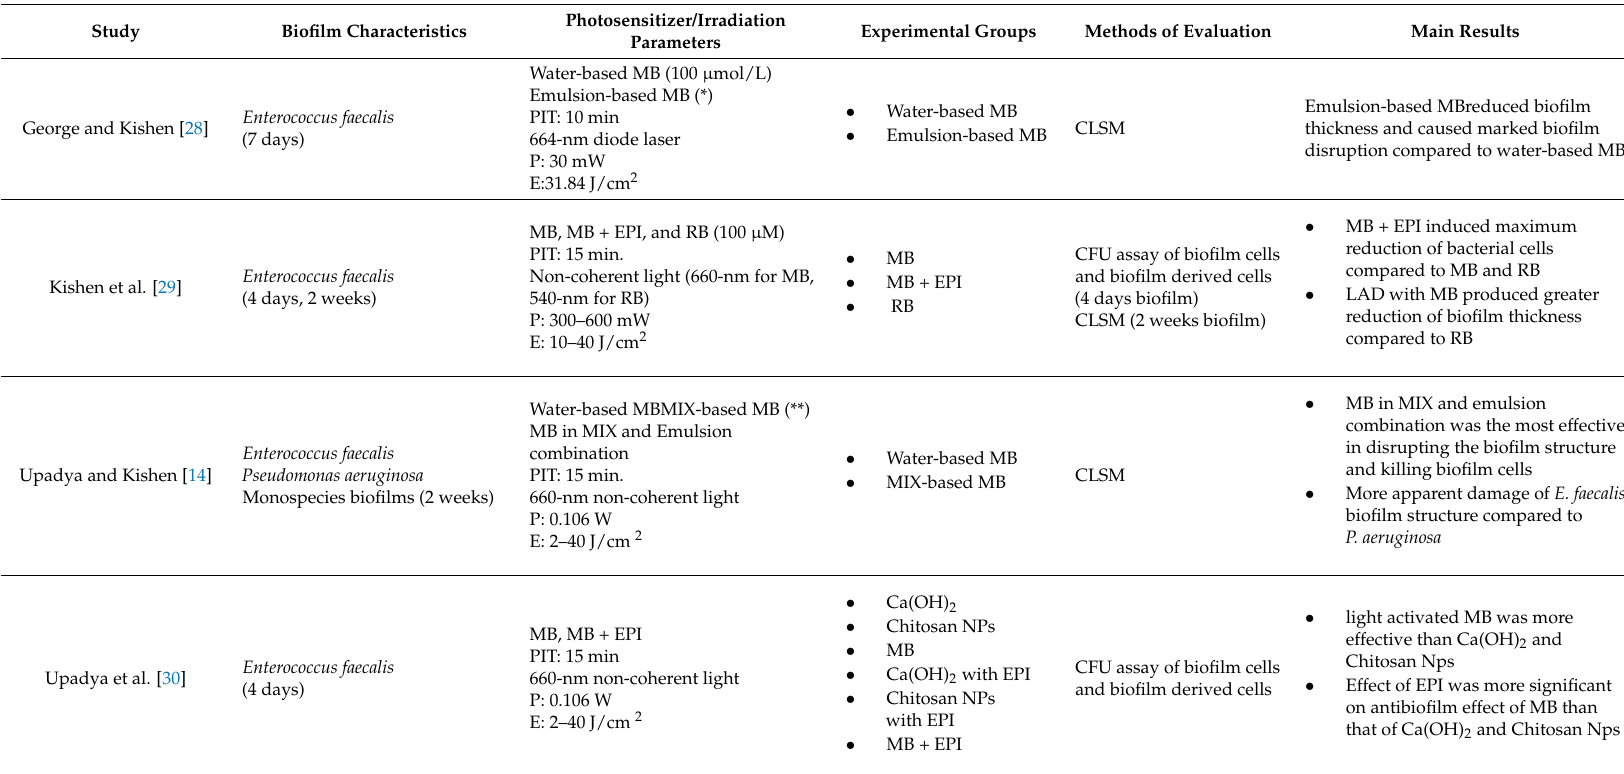
Table 3. General characteristics of studies on the antibiofilm effect of light activated disinfection